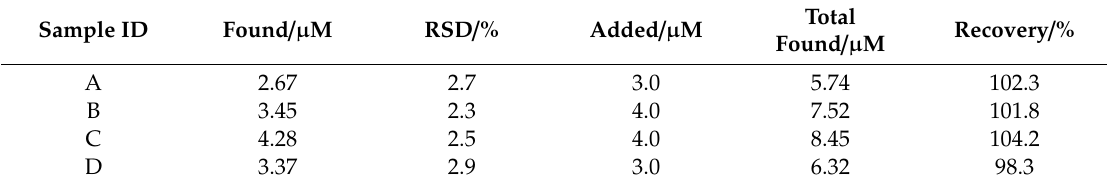
Table 3. The results for the determination of Trp in blood serum samples ( n = 4).